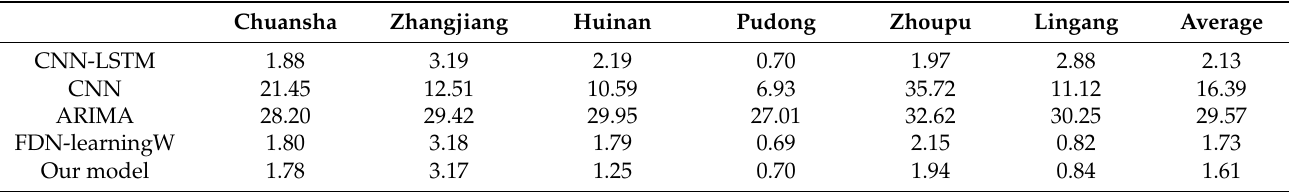
Table 2. Performance comparison of different models on RMSE.